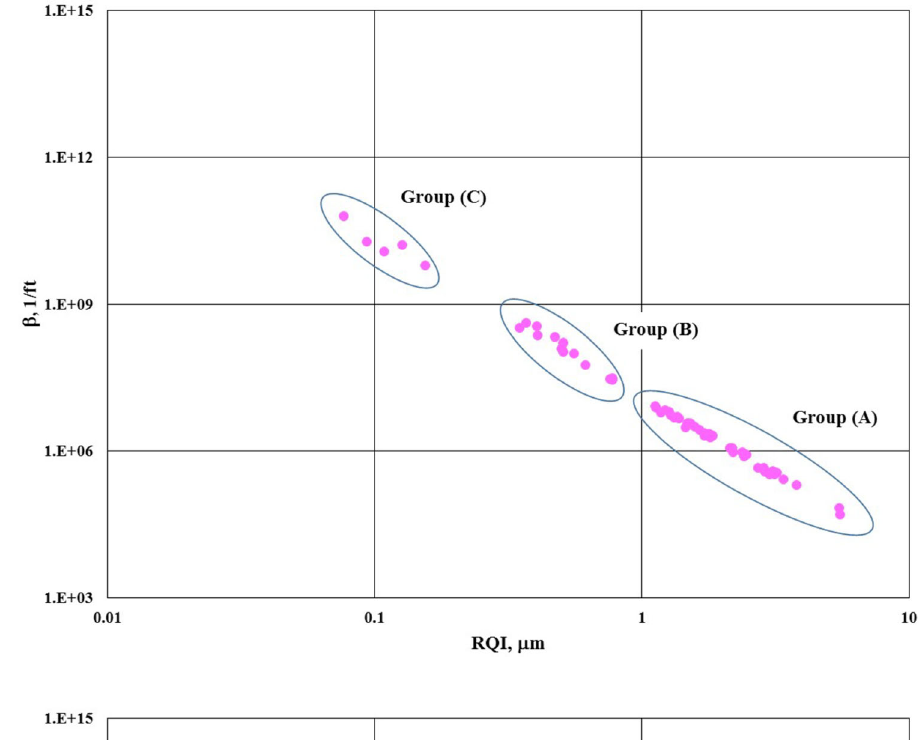
Fig. 7 Turbulence factor versus RQI (Amaefule et al.